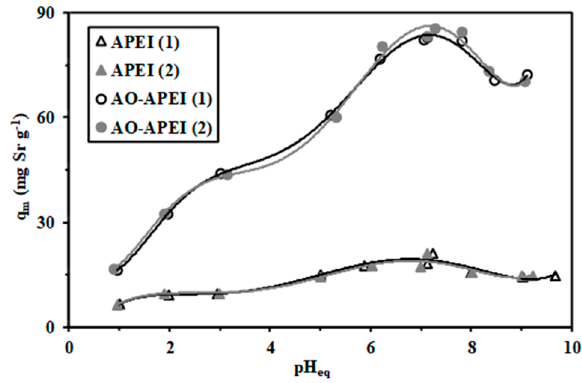
Figure 2. Effect of pH on Sr(II) sorption capacity onto APEI and AO-APEI sorbents—(duplicate experiments; sorbent dosage, SD: 0.375 g L − 1 ; C 0 : 29.7 mg Sr L − 1 ; temperature: 25 ± 1 °C; agitation speed: 140 rpm; contact time: 48 h).